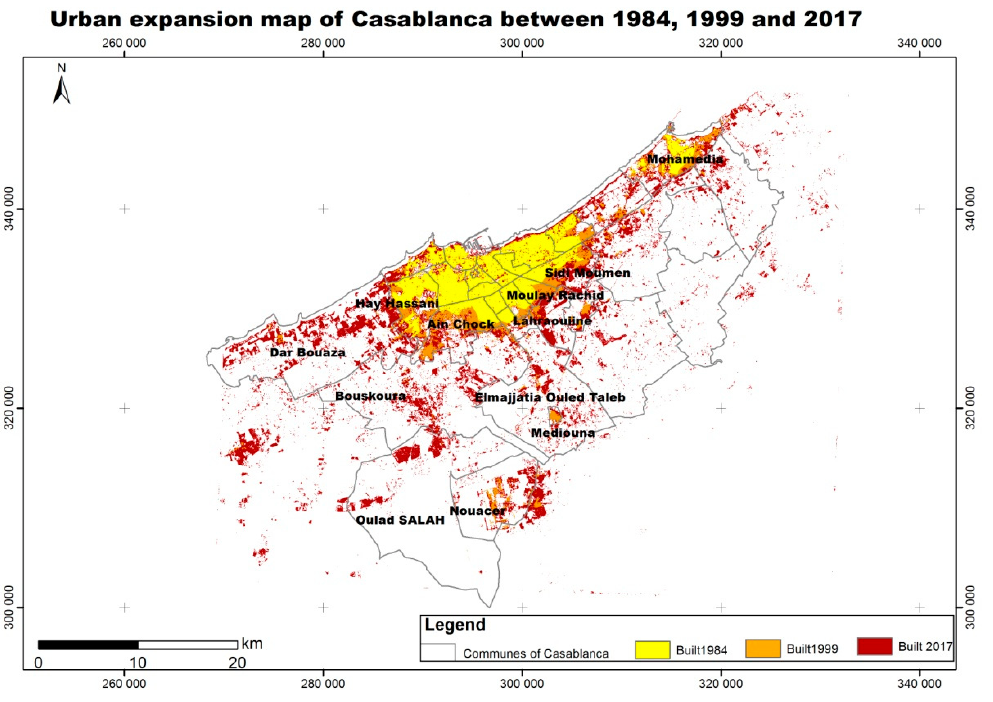
Figure 4. The urban expansion map of Casablanca in 1984, 1999, and 2017.